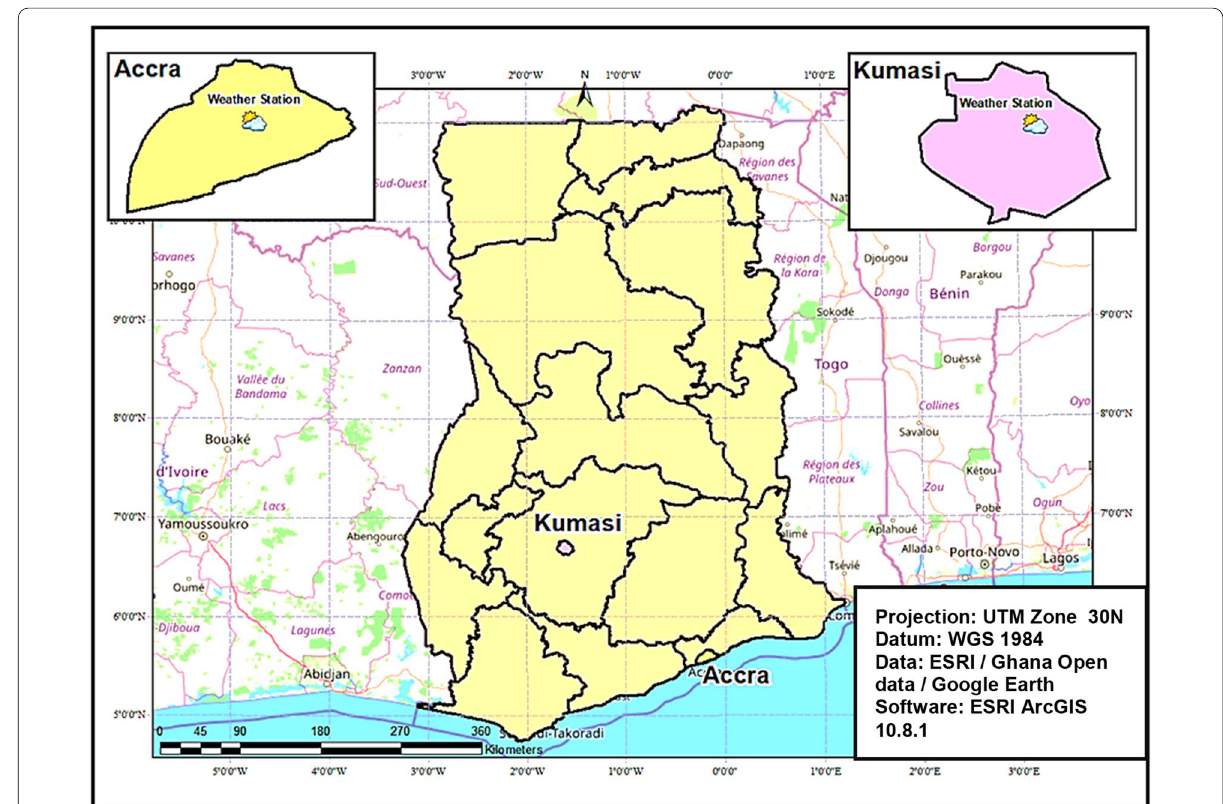
Fig. 1 Map of Ghana showing both cities and their meteorological